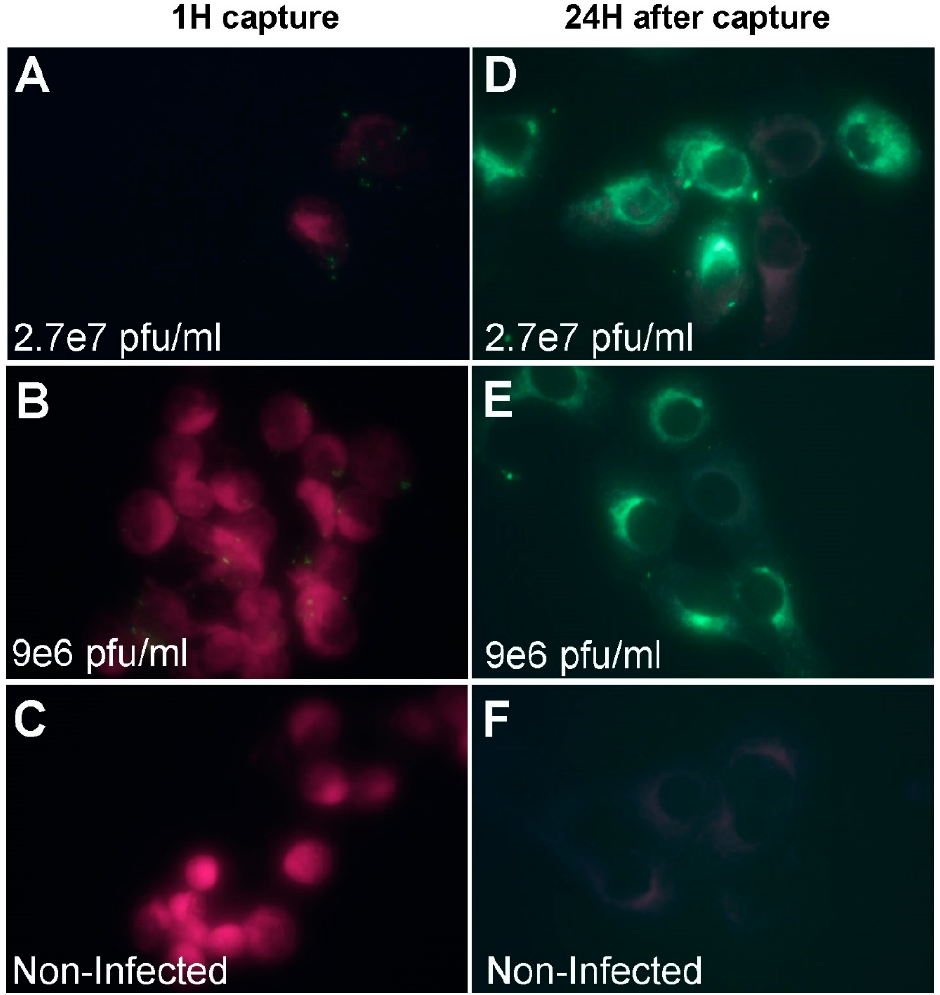
Figure 6. Fluorescence microscopy imaging of WNV after capture with Vero cells. ( A – C ) Suspended Vero cells were mixed with WNV at the indicated concentrations for one hour with shaking to allow attachment. After capture, the cells were pelleted and processed to IFA. Cells were labeled with purple color and viruses are in green. ( A , B ) Multiple viral particles could be observed on the cells surface. ( C ) Non-infected cells did not show any staining. ( D , E ) Suspended Vero cells were mixed with WNV at the indicated concentrations for one hour with shaking to allow attachment. After capture the cells were pelleted and seeded in Labtek dishes for additional 24 h to allow virus replication. Intensive cellular staining was noted at 2.7 × 10 7 pfu / mL and 9 × 10 6 pfu / mL virus concentrations. ( F ) No cellular staining was observed in non-infected cells after 24 h of incubation.